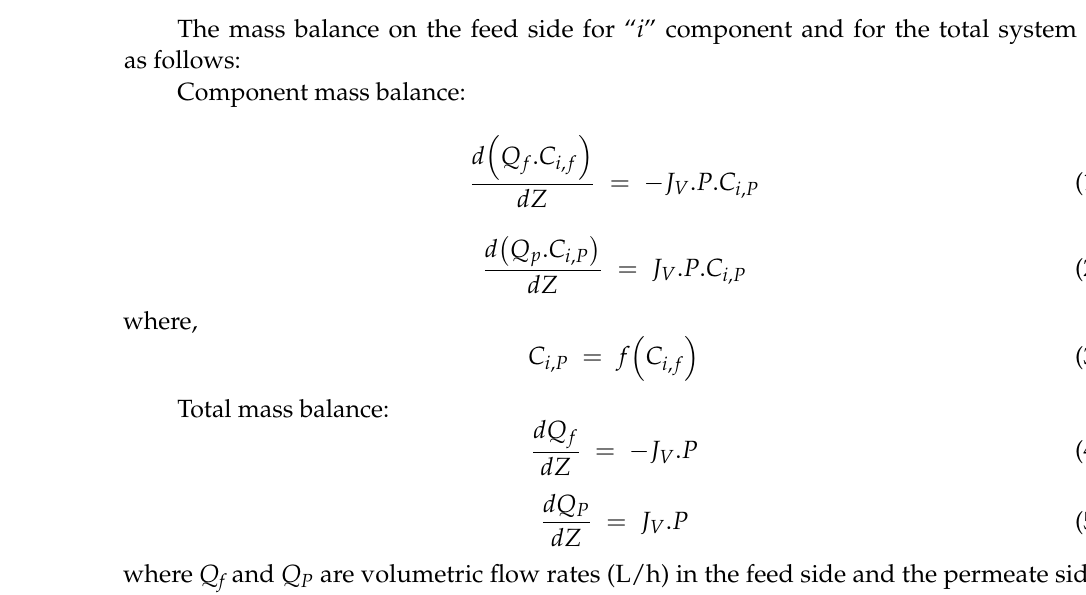
Figure 2. Schematic diagram of flat ‐ sheet membrane.